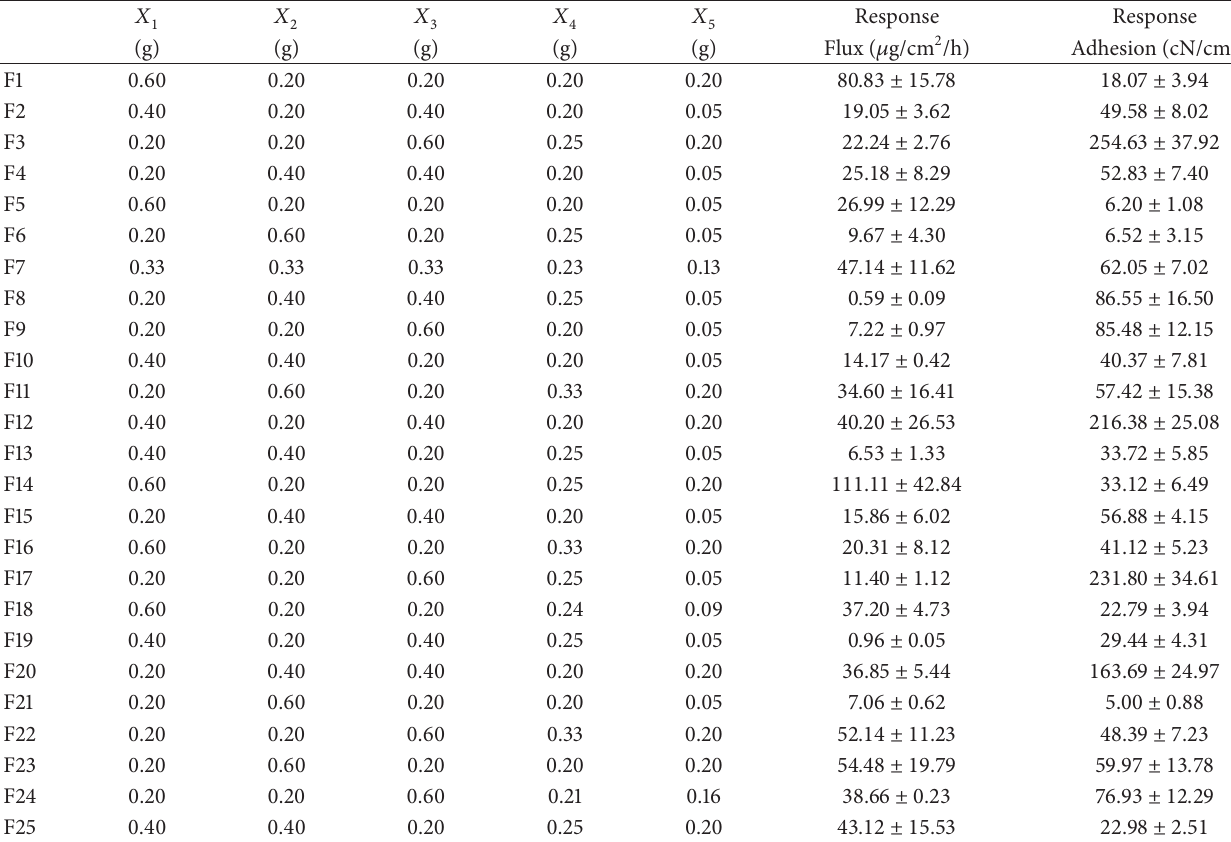
Table 1: The composition and responses (penetration rate and adhesion) of model arecoline-loaded